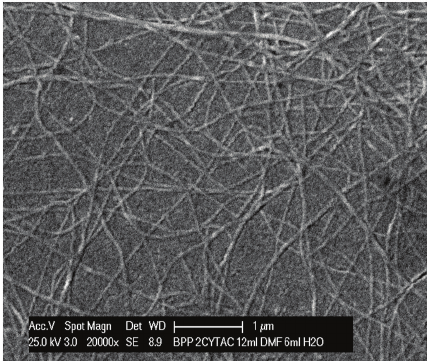
Figure 4: SEM micrographs of nanofibrous network assemblies formed from compound 1 in